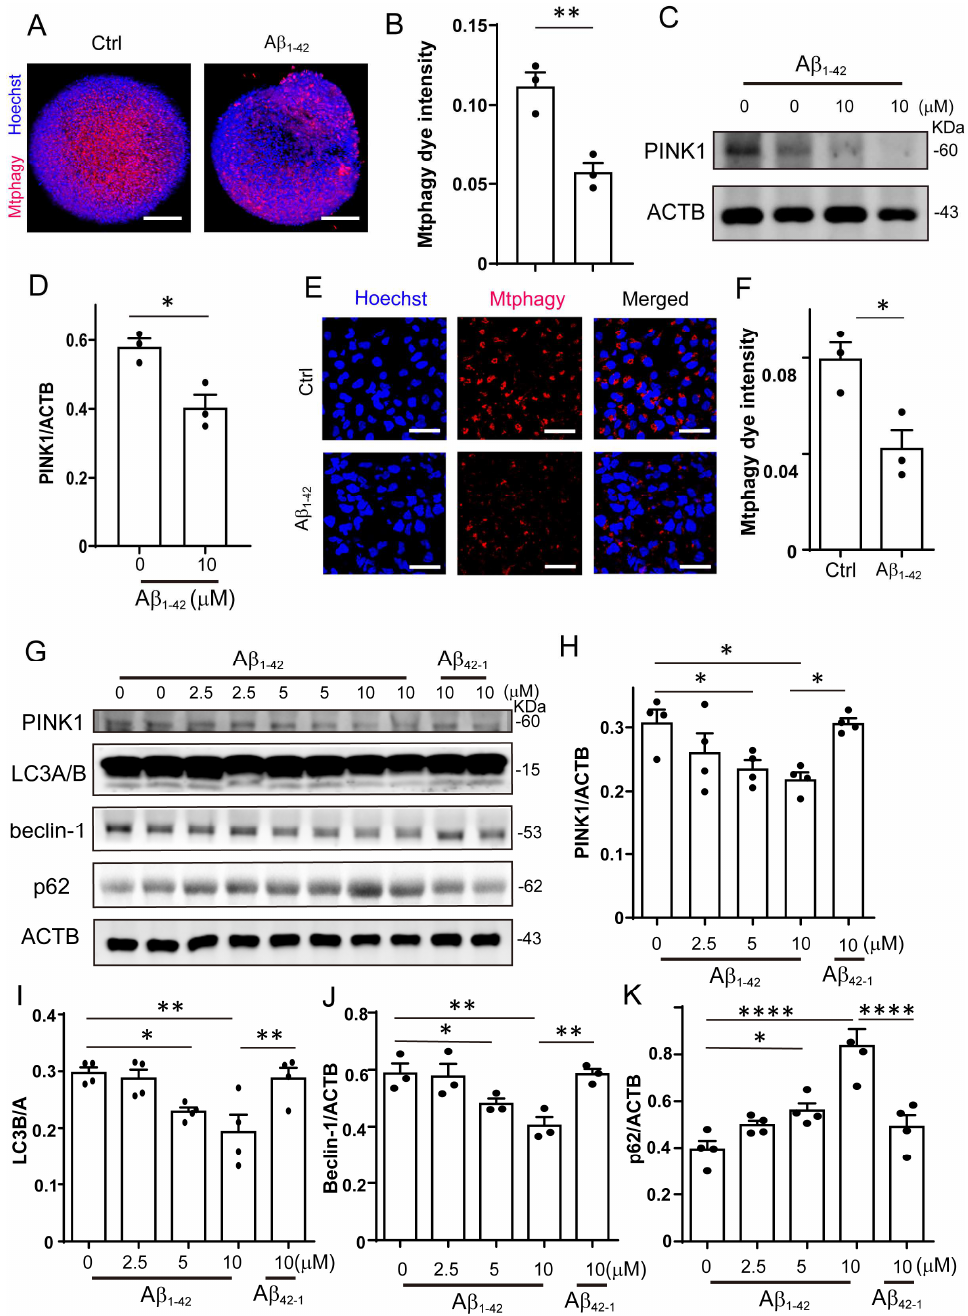
Figure 2. Mitophagy was impaired by Aβ 1-42 in brain organoid and NPCs. ( A ) The representative images of mitophagy in organoids treated with Aβ 1-42 (10 μM) for 8 days; scale bars, 200 μm. ( B ) The quantification of mitophagy intensity of ( A ). ( C ) The protein level of PINK1 was determined by Western blotting under Aβ 1-42 (10 μM) treatment in organoids. ( D ) The quantification of the relative expression level of PINK1 in ( C ). ( E ) The representative images of mitophagy in NPCs treated with Aβ 1-42 (10 μM) for 48 h; scale bars, 50 μm. ( F ) The quantification of mitophagy intensity of ( E ). ( G ) The protein level of PINK1, LC3A/B, Beclin-1, and p62 were determined by Western blotting under Aβ 1-42 (10 μM) treatmen in NPCs. ( H – K ) The quantification of the relative expression level of PINK1, LC3A/B, Beclin-1, and p62 in ( E ). The data are presented as mean ± SEM, n ≥ 3 independent experi- ments; * p < 0.05, ** p < 0.01, **** p < 0.0001, analyzed by one-way ANOVA followed by Bonferroni’s test.